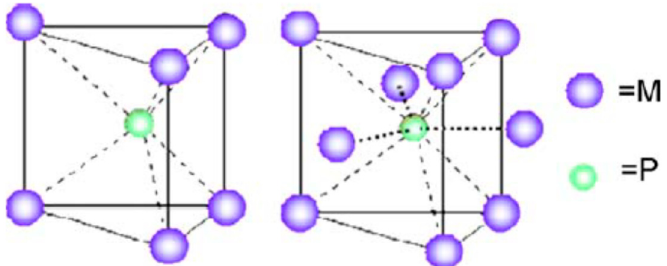
Figure 1. Triangular prism and tetrakaidecahedral structures of phosphides. (Reproduced from the work of [21] with permission).